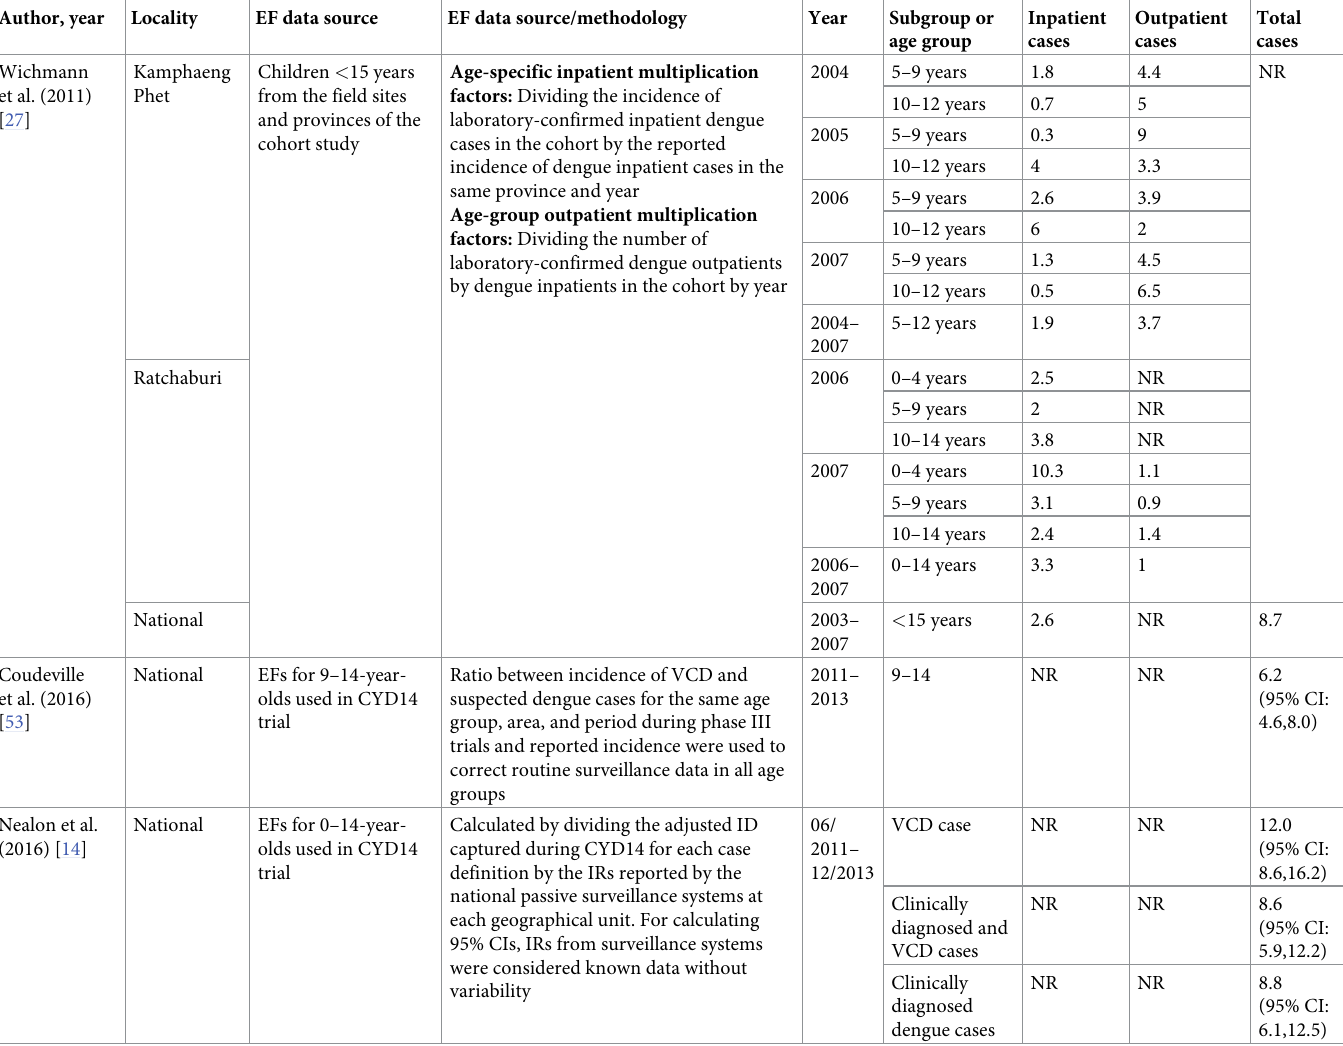
Table 1. Expansion factors by locality, patient subgroup/age, and healthcare setting. CI, confidence interval; EF, expansion factor; ID, incidence density; IRs, incidence rates; NR, not reported; VCD, virologically confirmed